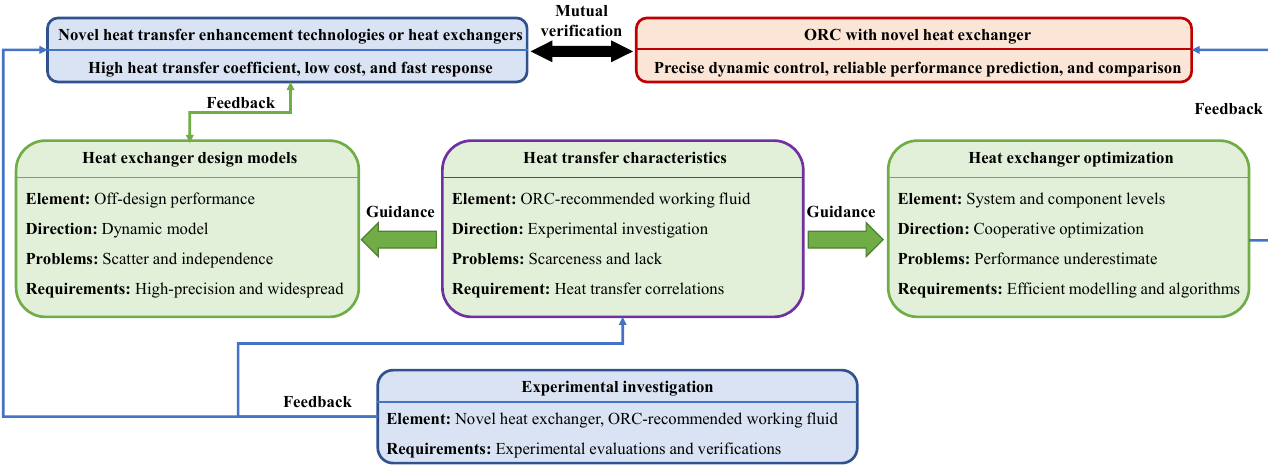
Figure 22. Future research directions of ORC with heat transfer enhancement technologies.